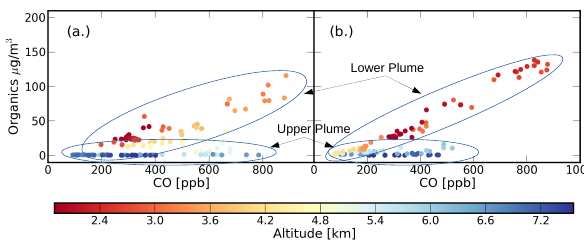
Figure 5. In situ measurements of organic particulate mass plotted against CO as measured by instruments aboard the BAe-146 ARA during (a) an ascent, and (b) the subsequent descent on 20 July 2011 during flight no. 622. Exact locations of the profiles are given in the text and plotted in Fig. 6. Both profiles revealed the presence of two vertically separated plumes of CO, and that the upper plume contained little or no